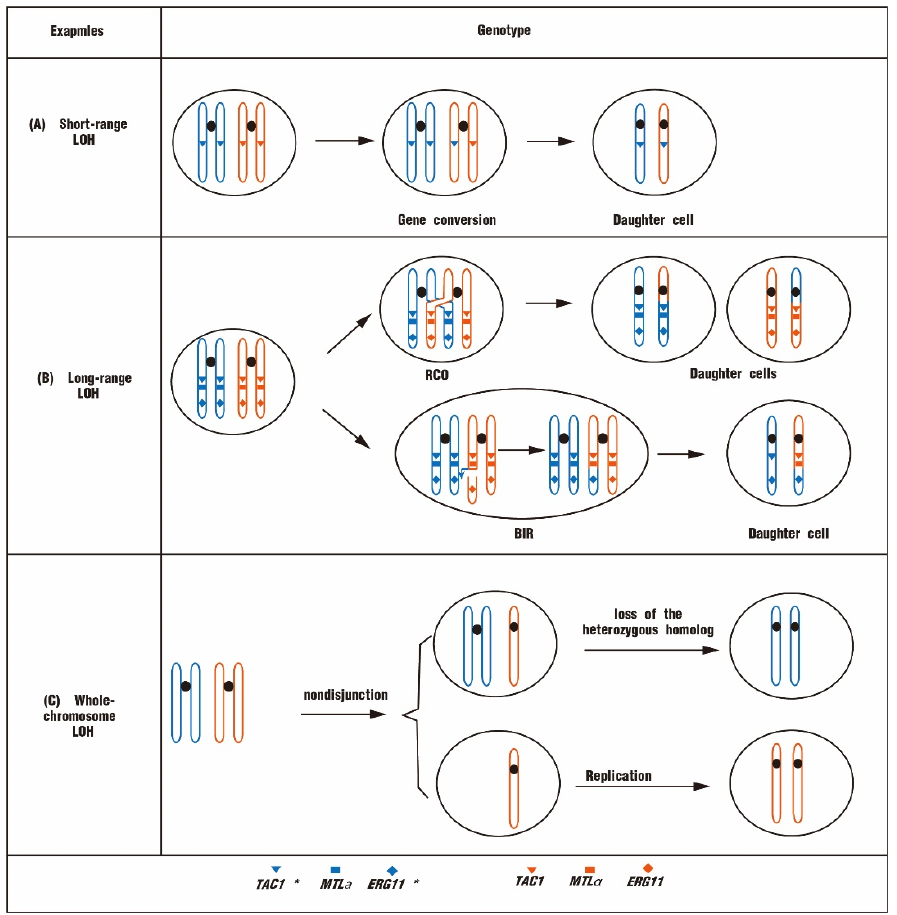
Figure 3. Three different types of LOH are associated with fluconazole resistance in yeast. ( A ) Short- range LOH that is usually produced by gene conversion through drug-resistant mutant genes, leading to an increased copy number of drug-resistant genes. ( B ) Long-range LOH. It results from RCO or BIR events, with intact replication or exchange from the break site to the telomere. ( C ) Whole- chromosome LOH. Nondisjunction or chromosome missegregation events can yield trisomic or monosomic progeny, respectively. Whole-chromosome LOH arises by either loss of the heterozy- gous homolog in trisomic individuals or reduplication of the hemizygous homolog in monosomic individuals. TAC1* and ERG11* represent the genes with mutations.